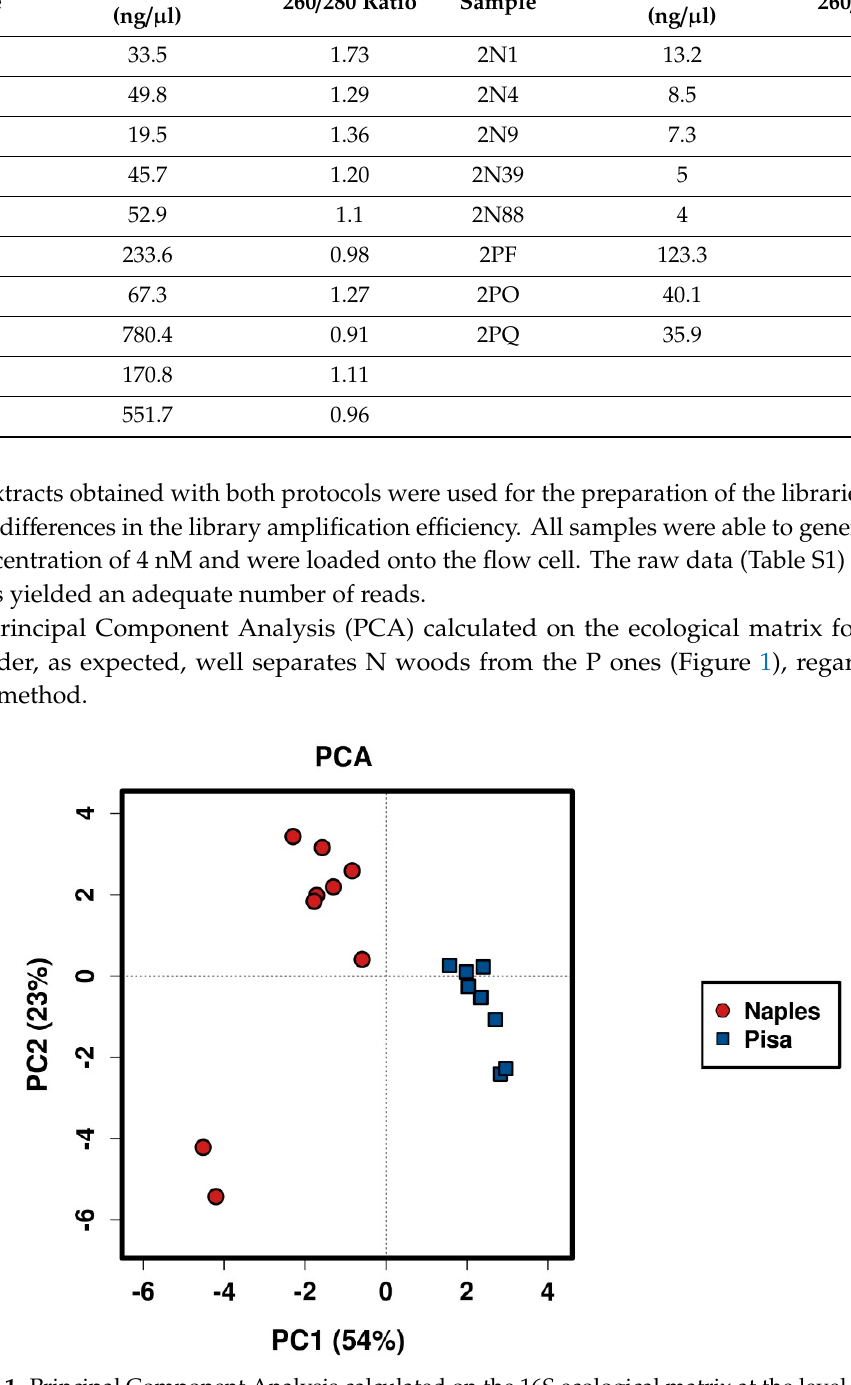
Figure 1. Principal Component Analysis calculated on the 16S ecological matrix at the level of order. The samples from Naples (red dots) and Pisa (blue square) show distinct clusters on the first axis that accounts for the 54% of the total variance.